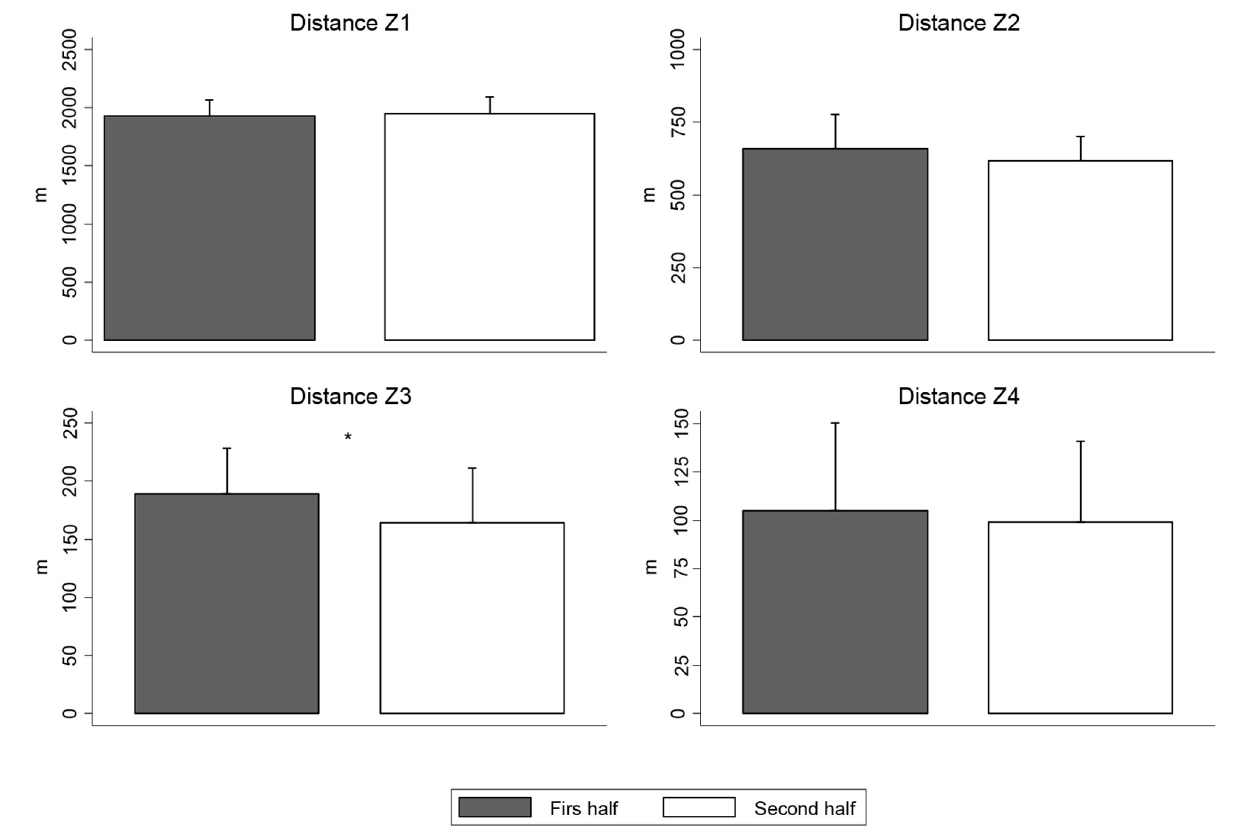
FIGURE 2 | Distance covered in different speed ranges. *Significant differences between first and second half for a given variable ( p < 0.05). Z1, zone 1 (0–10 km · h − 1 ); Z2, zone 2 (10.1–15 km · h − 1 ); Z3, zone 3 (15.1–18 km · h − 1 ); Z4, zone 4 ( > 18.1 km · h − 1